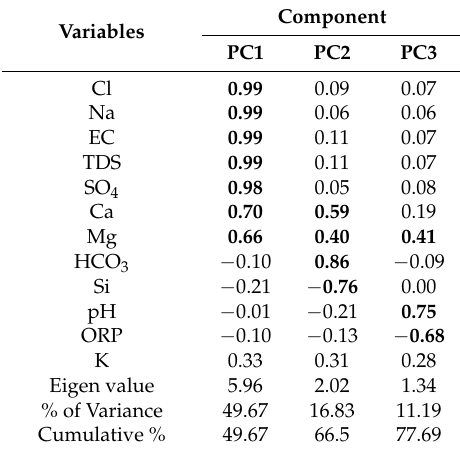
Table 3. Principle component analysis.